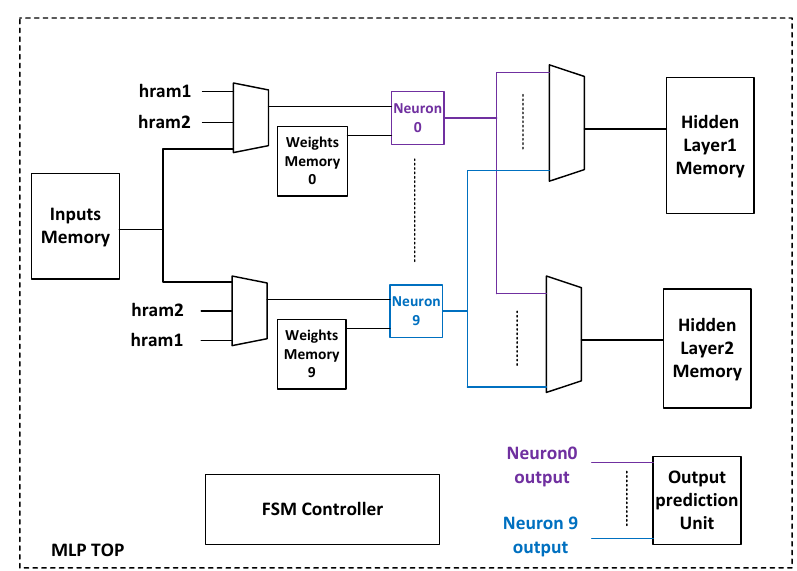
Figure 4. Block Diagram of the Network used for SVHN